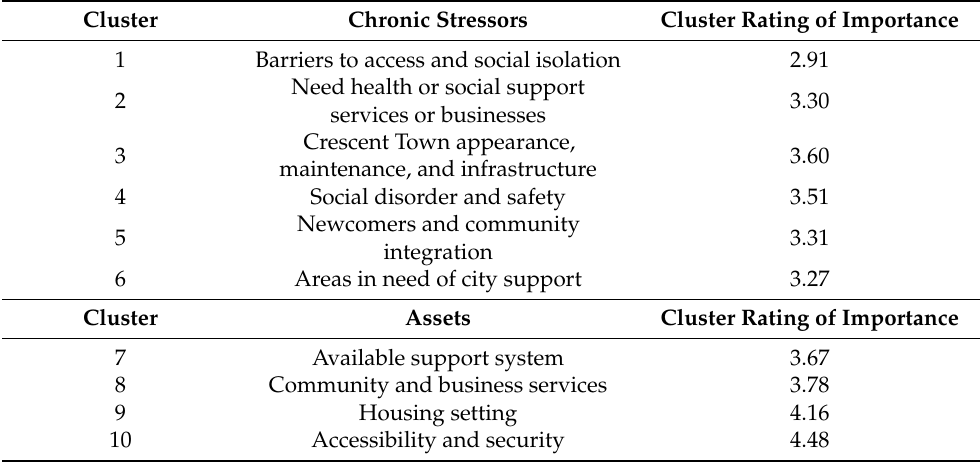
Table 1. Importance rating of clusters of chronic stressors and